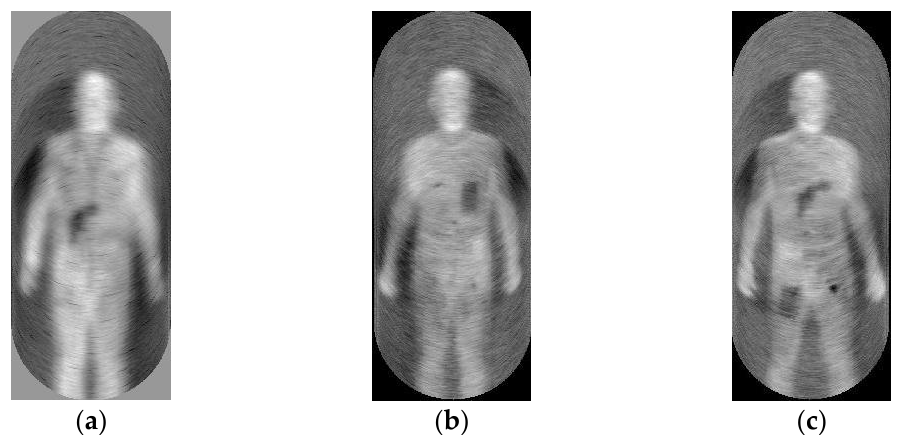
Figure 7. Samples of THz passive image dataset. ( a ) Category 1: carrying a gun model. ( b ) Category 2: carrying a cell phone. ( c ) Category 3: carrying two objects.